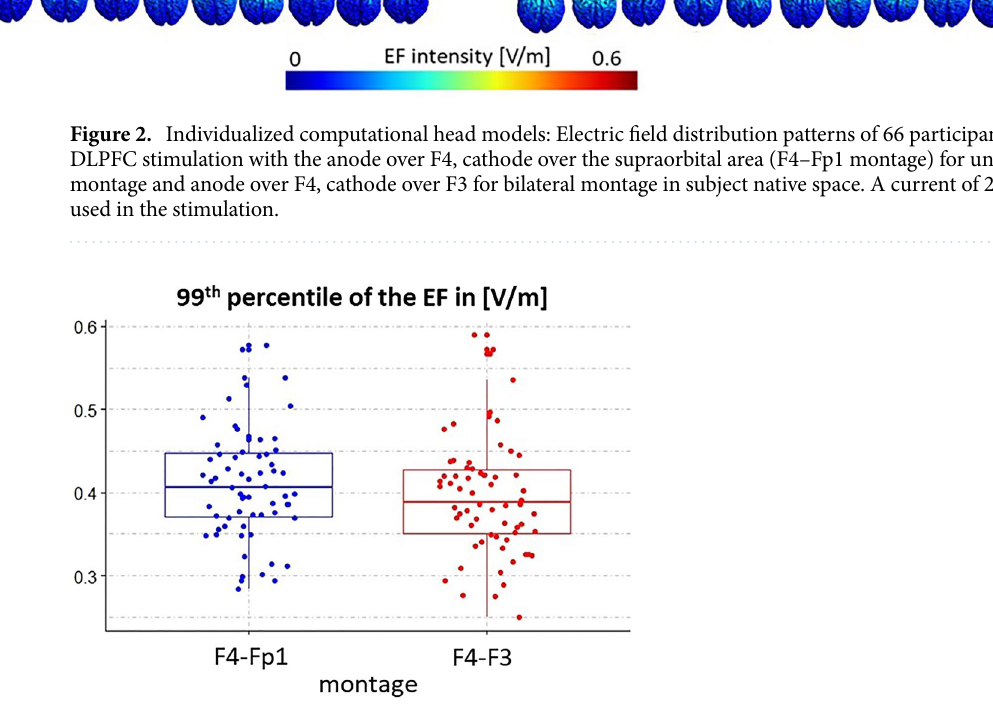
Figure 3. 99th percentile of the electric field in whole-brain analysis: Boxplots show the median of the 99th percentile and interquartile ranges of the electric fields in the whole-brain analysis. Dots represent the data for individual subjects. Results are reported for both montages F4–Fp1 (in blue) and F4–F3 (in red)